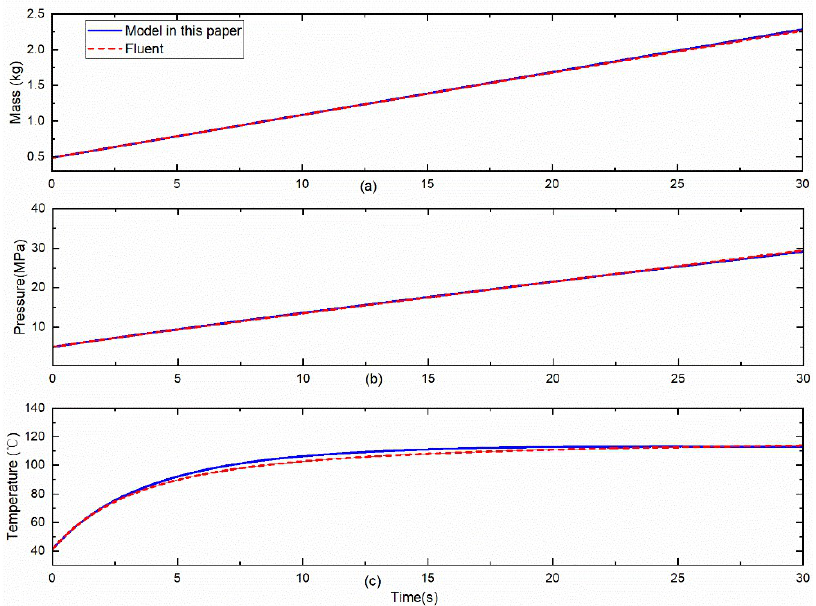
Figure 17. Comparing results of model in this paper and Fluent. ( a ) Mass of gas; ( b ) Pressure of gas; ( c ) Temperature of gas.